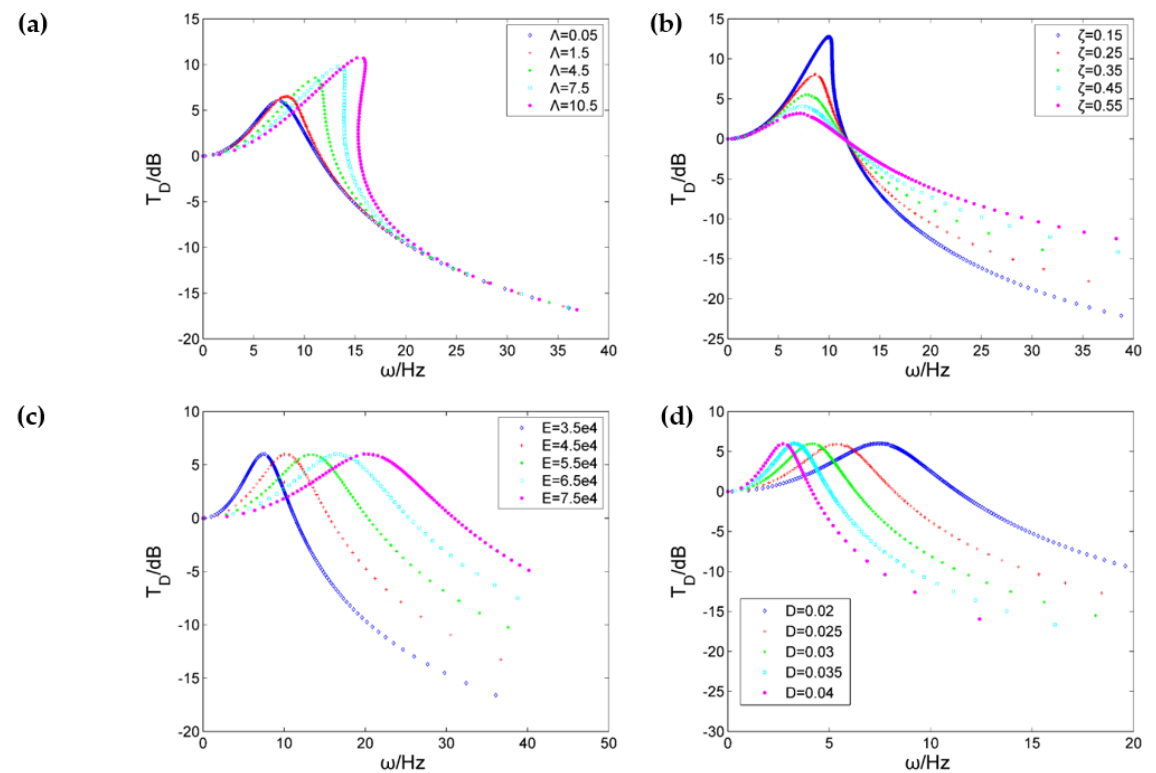
Figure 10. Vibration transfer rate curves under different parameters. ( a ) Excitation amplitude ( ζ = 0.3; D = 0.02 m; E = 3.5 × 10 4 Pa); ( b ) viscous damping ratio ( Λ = 0.05 m/s 2 ; D = 0.02 m; E = 3.5 × 10 4 Pa); ( c ) Young’s modulus ( Λ = 0.05 m/s 2 ; ζ = 0.3; D = 0.02 m); ( d ) section diameter ( Λ = 0.05 m/s 2 ; ζ = 0.3; E = 3.5 × 10 4 Pa).